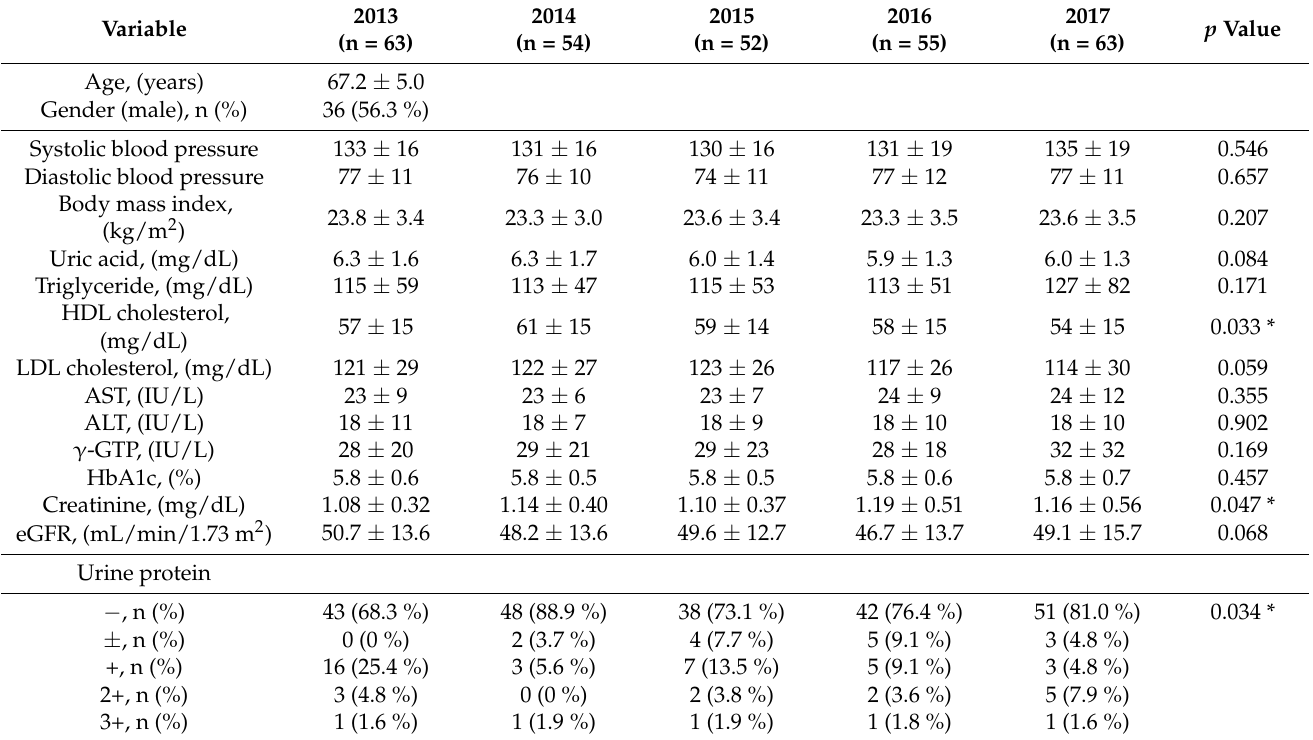
Table 2. Characteristics of high-risk subjects for advanced renal dysfunction in each year.